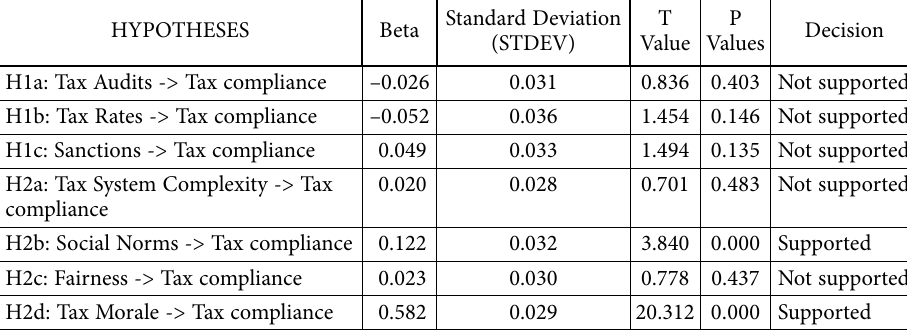
Table 6. Structural estimates (hypotheses